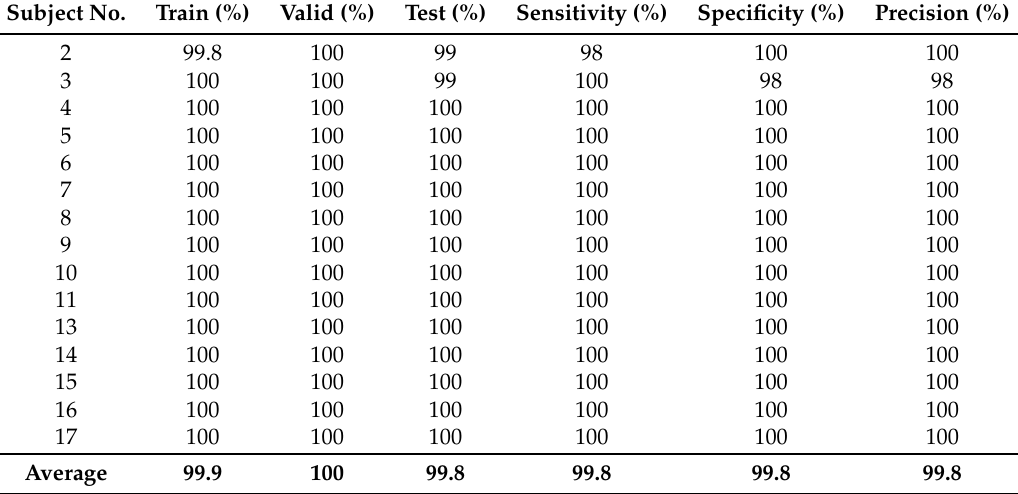
Figure 8. Confusion matrix for generic model using 20% of calibrated sample ( left : spatial images; right : frequency domain images). Table 4. The accuracy measures for the person-specific models using spatial